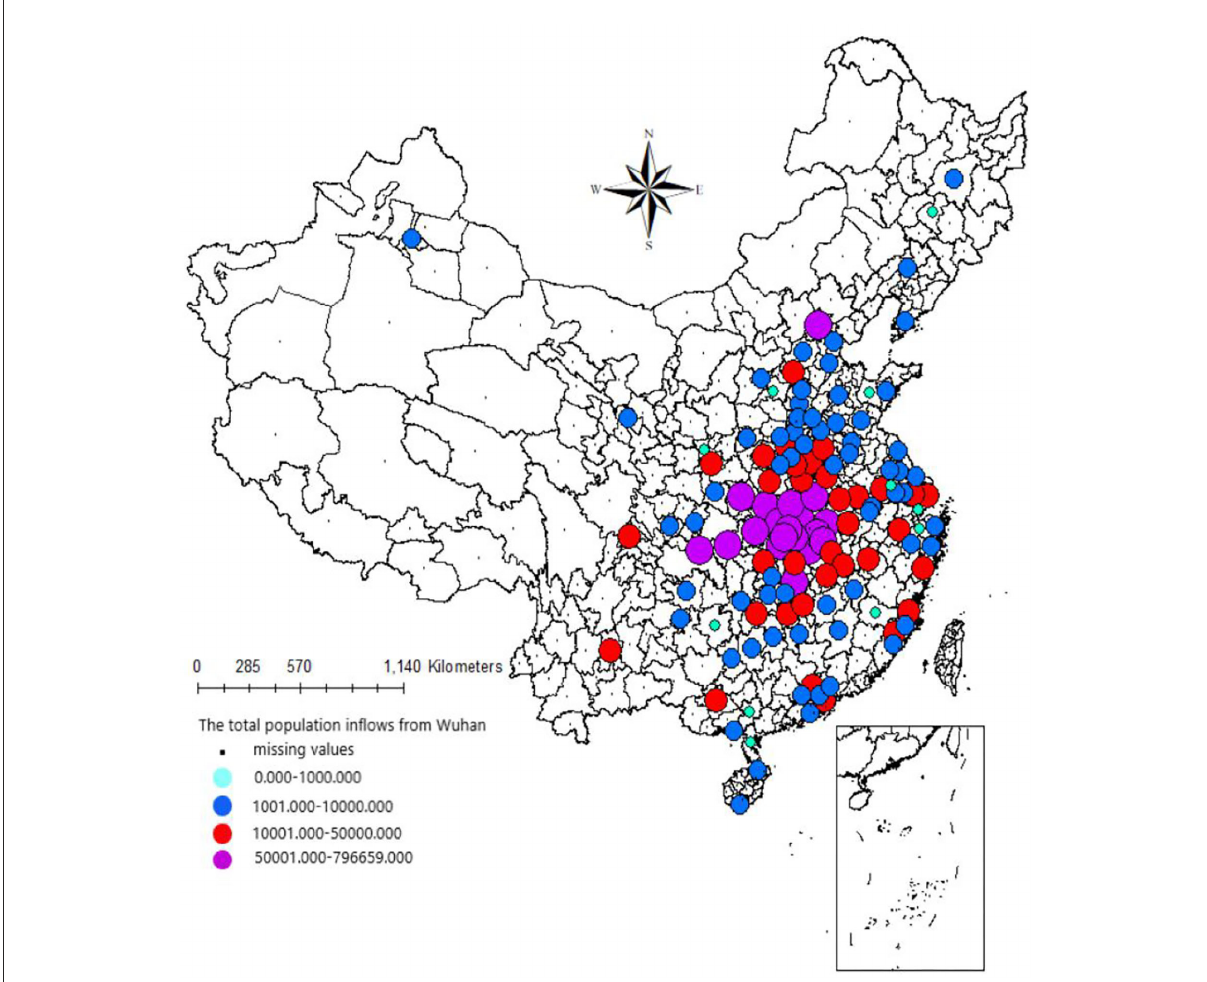
FIGURE1 Population inflow from Wuhan city to other cities in China before the Spring Festival. Data source: Baidu Migration Index of China. Available at: http://qianxi.baidu.com